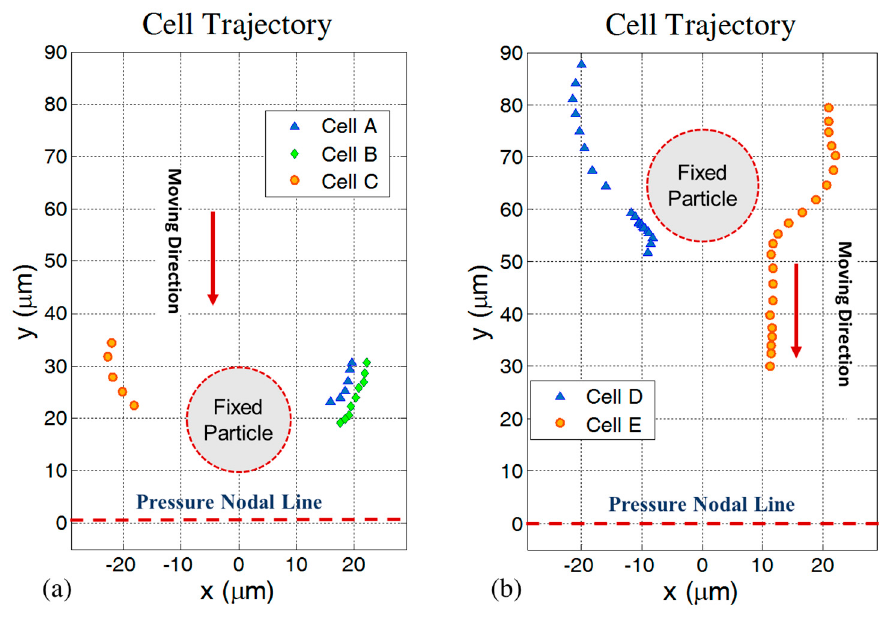
Figure 2. Trajectories of RBCs due to a combination of the primary and the secondary acoustic forces. ( a ) Three different experiments with the silica particle fixed at a vertical distance of 20 µm from the pressure nodal line, the latter set to y = 0. In the A, B, and C cases, the cells were trapped at the silica particle and stacked. Note that the shortest distance between the positions of the cells and the boundary of the fixed particle corresponds to the radius of the RBCs. ( b ) Two different experiments with the silica particle fixed at a vertical distance of 65 µm from the pressure nodal line. In both cases, cells D and E were separated from the fixed silica particle following a smooth contact.